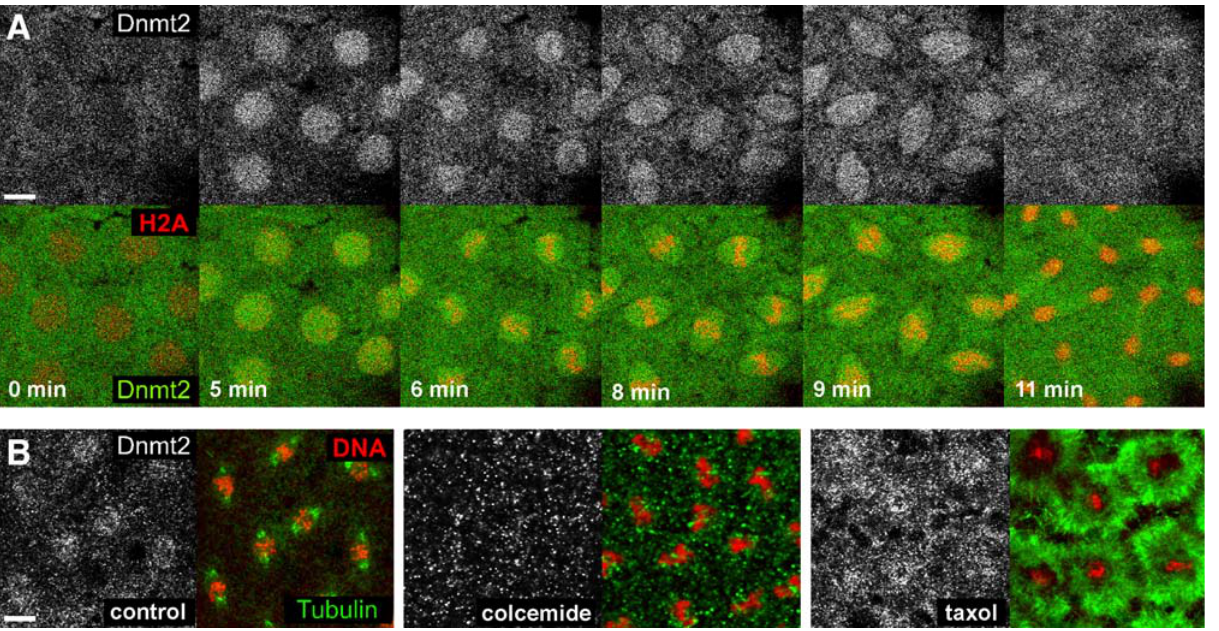
Figure 5. Dnmt2 localization to mitotic nuclei is dynamic and microtubuli-dependent. (A) Nuclear division cycle 10 embryos expressing pUbq- Dnmt2-EGFP and His2Av-mRFP1 were mounted on an open coverslip and viewed by dual wavelength time-lapse LSCM. Selected frames are shown for Dnmt2-EGFP (gray, upper panel) and as merged images (lower panel) with Dnmt2-EGFP in green and His2A-mRFP1 in red. A movie of the sequence is available as supporting material. (B) 1–3 h old embryos expressing pGeno-Dnmt2-EGFP were collected and fixed immediately (left panel), treated with colcemide (middle panel) or with taxol (right panel) in order to disrupt or stabilize microtubuli, respectively. Metaphase chromosomes are shown with Dnmt2 (gray), DNA (red) and ^ -tubulin (green). While Dnmt2-EGFP is maintained around metaphase plates in taxol-treated embryos, the protein is delocalized in colcemide-treated embryos. Scale bars: (A) 10 m m; (B) 5 m m.